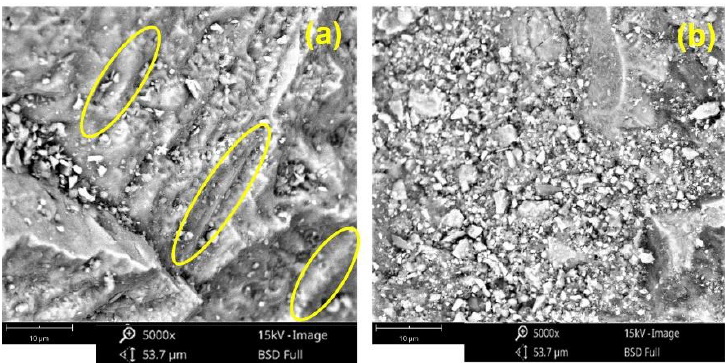
Figure 3. Images of SEM for iron ore ( a ) before and ( b ) after dehydration.